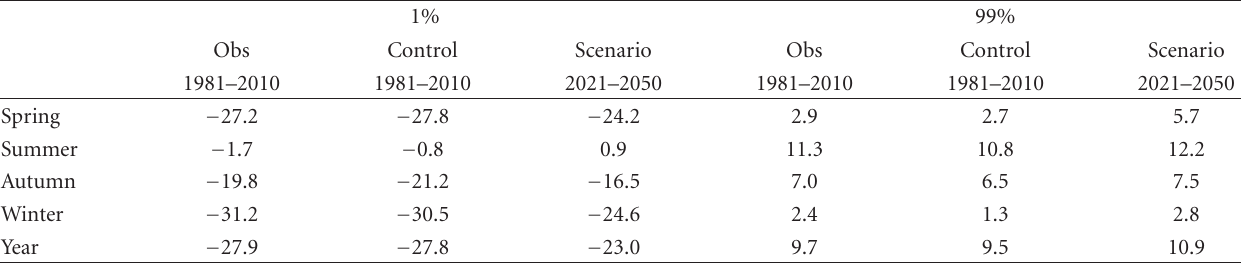
Table 8: Percentiles (1 and 99) of daily temperatures ( ◦ C) at Svalbard Airport in present and future climate. Control and scenario values are based on postprocessed temperatures from MPI92a.